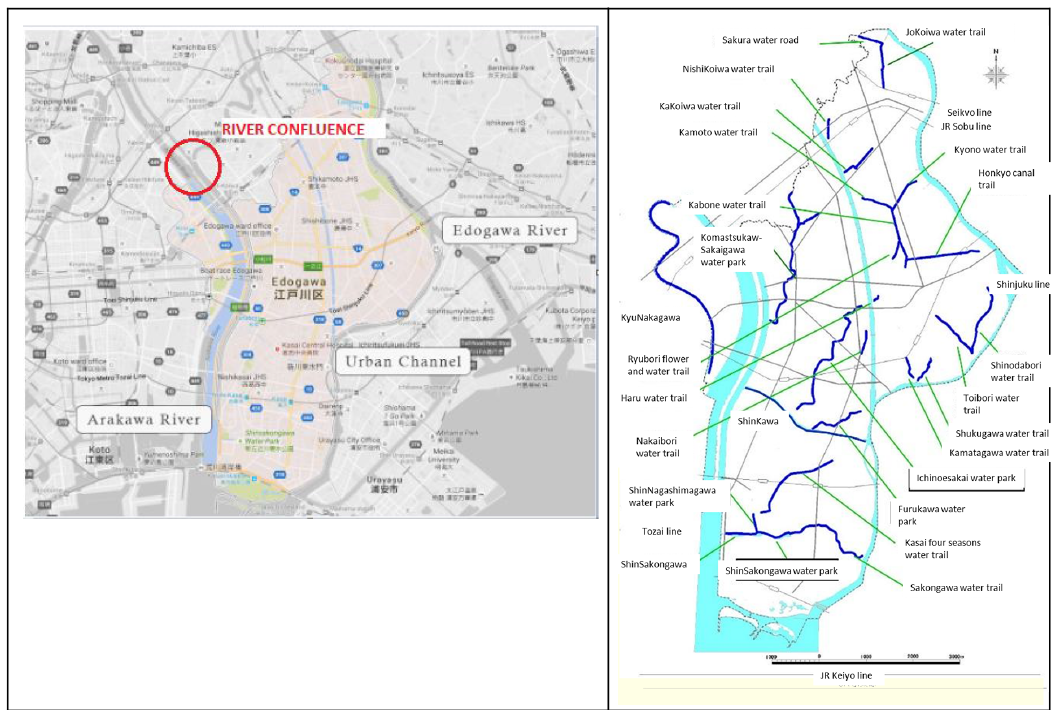
Figure 5. Map of Edogawa-ku with the rivers ( left ) and the waterways within its vicinity [19,23] (Map source: Google Maps).